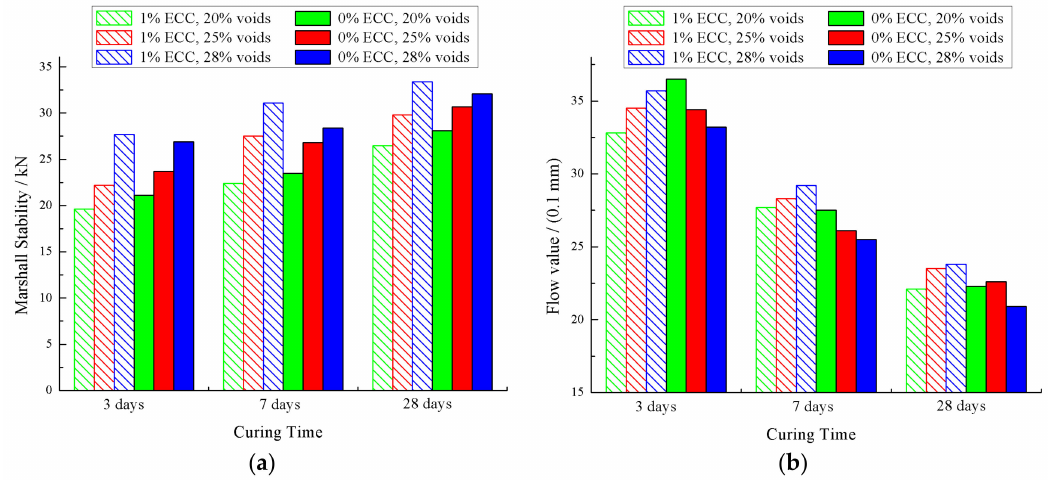
Figure 10. Marshall test results of SFP materials. ( a ) Results of the Marshall stability test; ( b ) Results of the flow